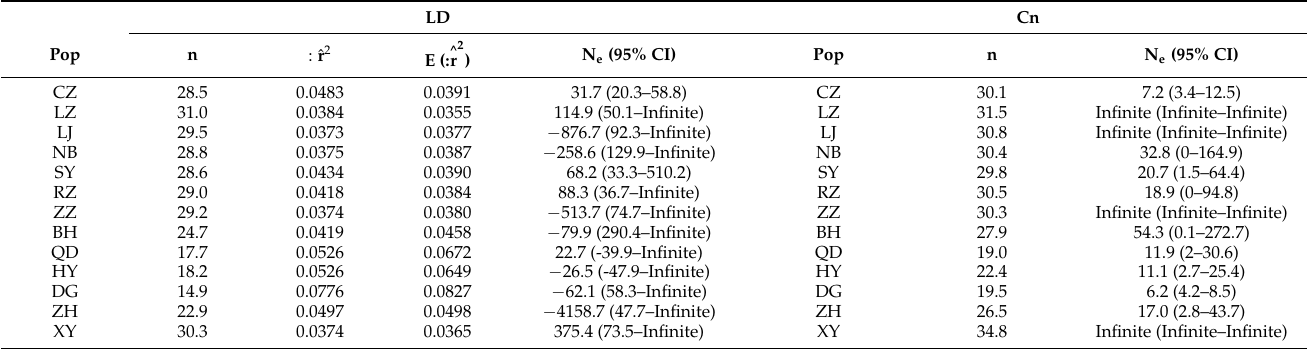
Table 5. Effective population sizes (N e ) for R. philippinarum populations estimated by the linkage disequilibrium (LD) and molecular coancestry (Cn)